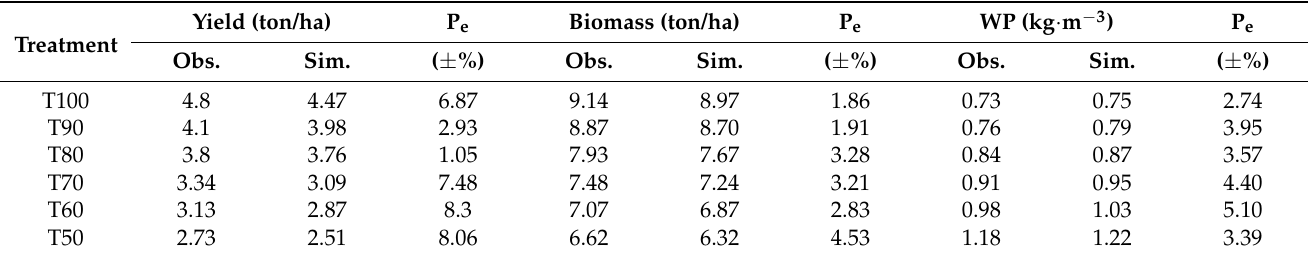
Table 8. The results of model validation for grain yield, biomass, and water use efficiency for the winter wheat crop under different irrigation conditions (2019).